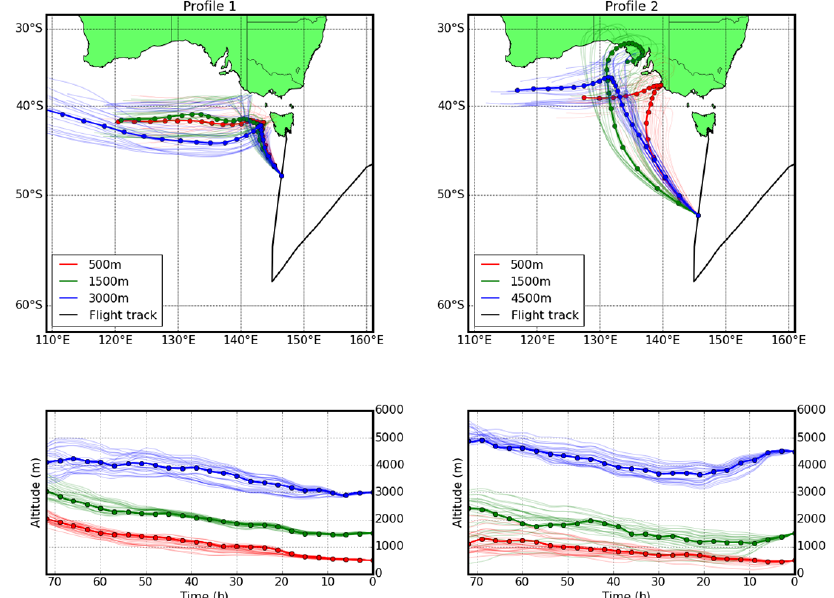
Figure 7. 72h HYSPLIT Back trajectory ensembles for profiles 1 and 2, with arrival heights indicated in the legends. Back trajectories were calculated with 1 ◦ horizontal resolution Global Data Assimilation System meteorological data, with the different ensemble members repre- senting perturbations from the aircraft location of 1 grid space in the horizontal and 0 . 01 σ (about 250m) in the vertical. The “deterministic” trajectories are heavier weighted lines with 3 hourly circle markers for each